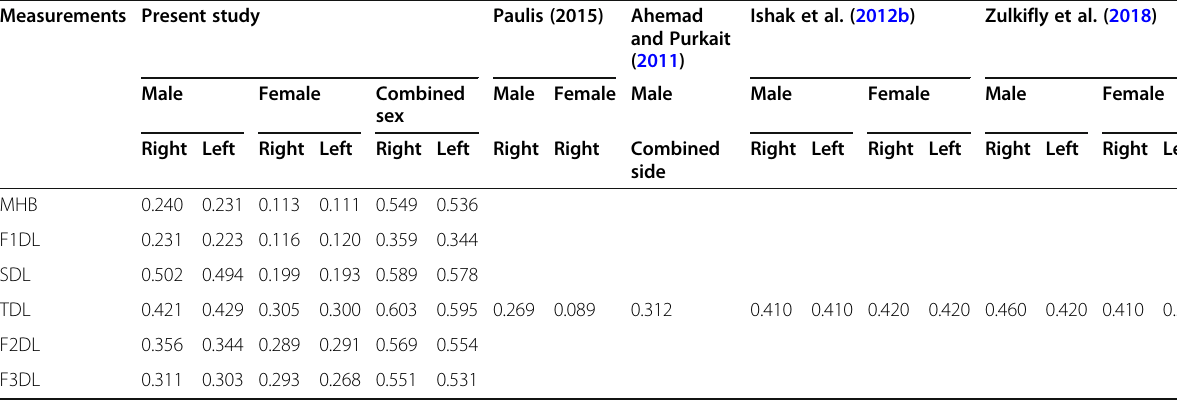
Table 6 Comparison of coefficient of determination ( R 2 ) among different studies Measurements Present study